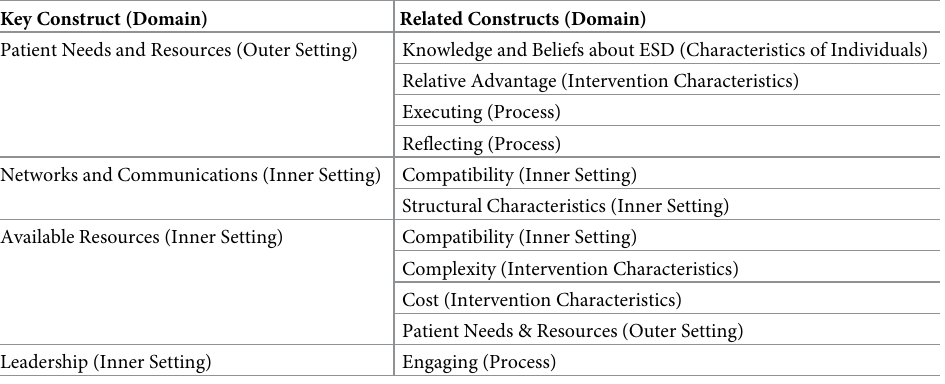
Table 6. Key constructs Identified by staff and their relationships with other